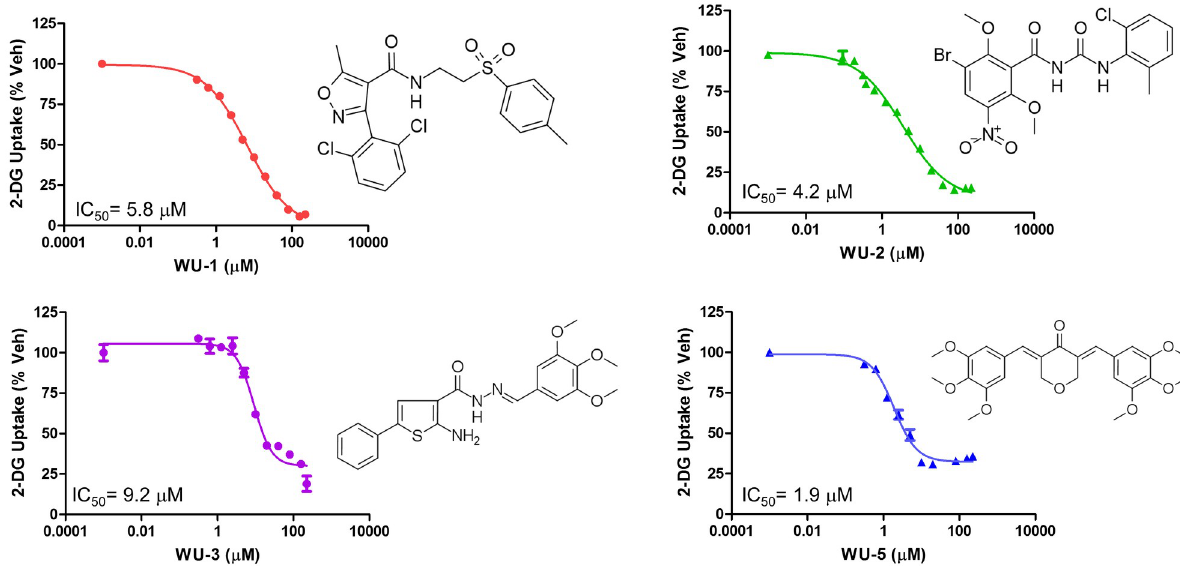
Fig 1. IC 50 determination of glucose uptake by PfHT-overexpressing HEK293 cells. Uptake of 2-DG by HEK293 cells overexpressing PfHT at increasing concentrations of the indicated compounds. IC 50 s were calculated using nonlinear regression analysis IC 50 determinations using GraphPad Prism 6.0. Uptake data are expressed as means ± SEMs (n = 3). Chemical structures of the compounds tested are shown for comparison.